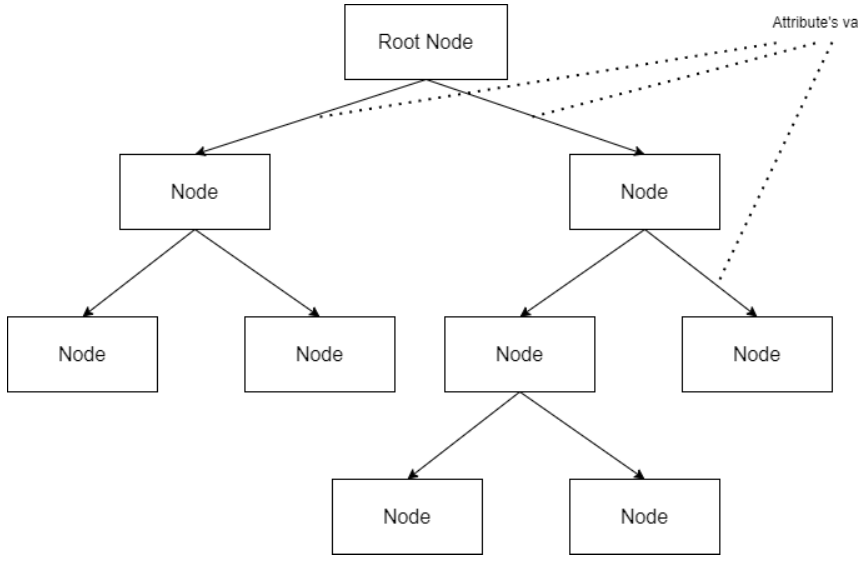
Figure 2. A brief schema of decision tree.